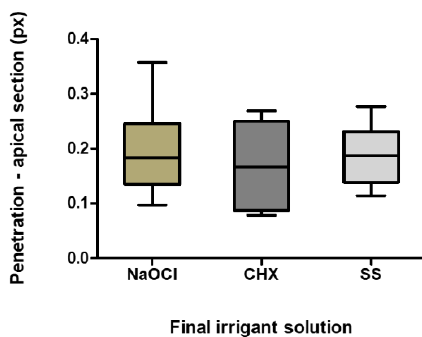
Figure 3. Sealer penetration in the apical sections (pixels). The boxplot shows the mean, minimum and maximum penetration of the different irrigants in the apical section.